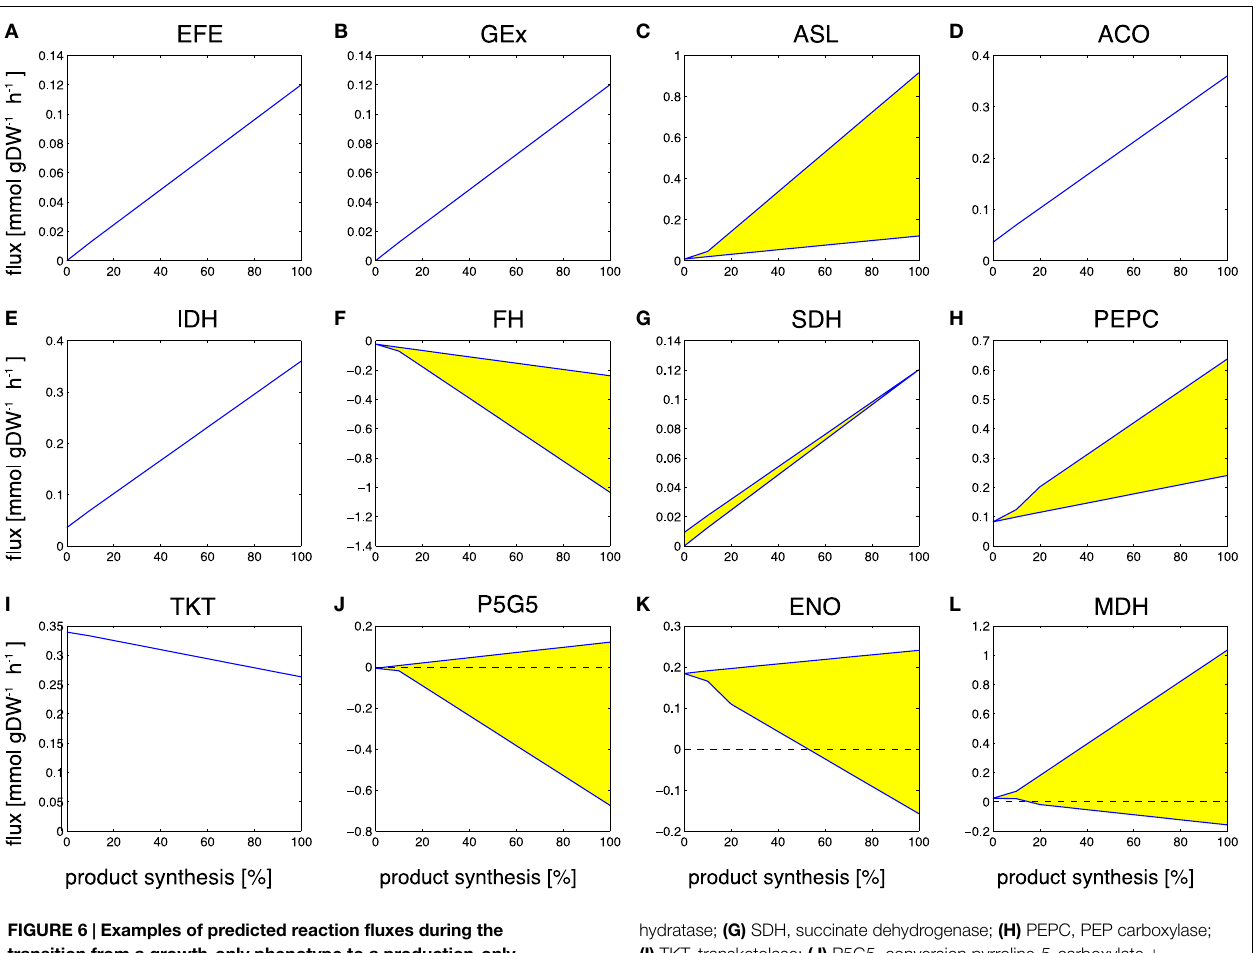
FIGURE 6 | Examples of predicted reaction fluxes during the transition from a growth-only phenotype to a production-only phenotype for ethylene . Yellow areas correspond to non-unique solutions (flux variability). Abbreviations: (A) EFE, ethylene-forming enzyme; (B) GEx, guanidine export; (C) ASL, argininosuccinate lyase; (D) ACO, aconitase; (E) IDH, isocitrate dehydrogenase; (F) FH, fumarate